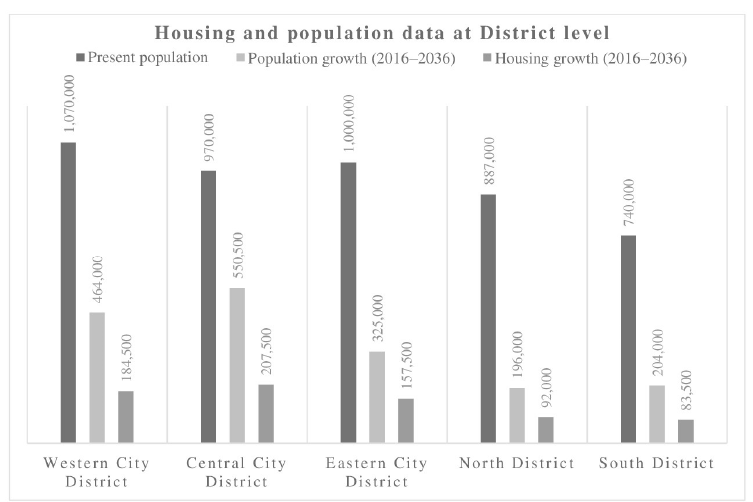
Figure 4. Current population and forecasted housing and population targets by District 2016 and 2036. Source: authors’ own. Data from the Greater Sydney Commission District Plans, accessed from https://www.greater.sydney/strategic-planning, on 14 February 2021. Figure 4 shows that the two districts of Western City and Central City (both parts of Greater Western Sydney) have been allocated 54% of the total new housing target. In con- trast, the East District received 22% and the North District received 13%. In reality, the geographic positions of the Central City and Western City were understood as Western Sydney prior to the inception of the Greater Sydney Commission in 2015. The Western City District LGAs include Blue Mountains, Camden, Campbelltown, Fairfield, Hawkes- bury, Liverpool, Penrith, and Wollondilly, and the Central City District LGAs include Blacktown, Cumberland, Parramatta, and The Hills. Central City is a new designation for a part of Western Sydney, as those LGAs are a fragment of the Greater Western Sydney region. It can be argued that the new designation, such as Western City, Central City, and Western Parkland City, is the neoliberal concept of cities within a city to achieve the state government’s urban strategic intent. Whatever the city’s name or designation, all areas fall over to the Greater Western Sydney region. The NSW Government’s existing plans add considerably to Sydney’s housing provi- sion. The government’s urban planning and development authorities significantly focus on the western part of Sydney as a suitable location for additional housing and popula- tions. The Department of Planning and Environment (DoP&E), the Greater Sydney Com- mission, and the infrastructure deal (Western Sydney City Deal) also target Western Syd- ney as a suitable place for urban growth. In this process of neoliberal urban growth, more and more people and housing are being addressed in Western Sydney’s suburbs. At the same time, advantaged areas have much lower housing targets than Western Sydney (Gellie 2019). The NSW planning department’s (DoP&E 2021) housing supply forecast over the five years from 2020–2021 to 2024–2025 for Sydney LGAs shows that the targets for new hous- ing in Western Sydney are significantly higher than the other areas. Around 61% of the new housing supply is allocated to Western Sydney LGAs. Even a local government area of Western Sydney is positioned for a 178% population increase by 2036 (GSC 2018a). Conversely, Sydney’s eastern and northern LGAs have only very small targets. It is also worth noting that Sydney’s eastern and northern regions are unlikely to meet their new housing provision targets because of strong local opposition (Farid Uddin et al. 2022). Farid Uddin et al. (2022) further argued that the eastern and northern residents and com- munity groups actively participate in urban planning consultation, they strongly oppose